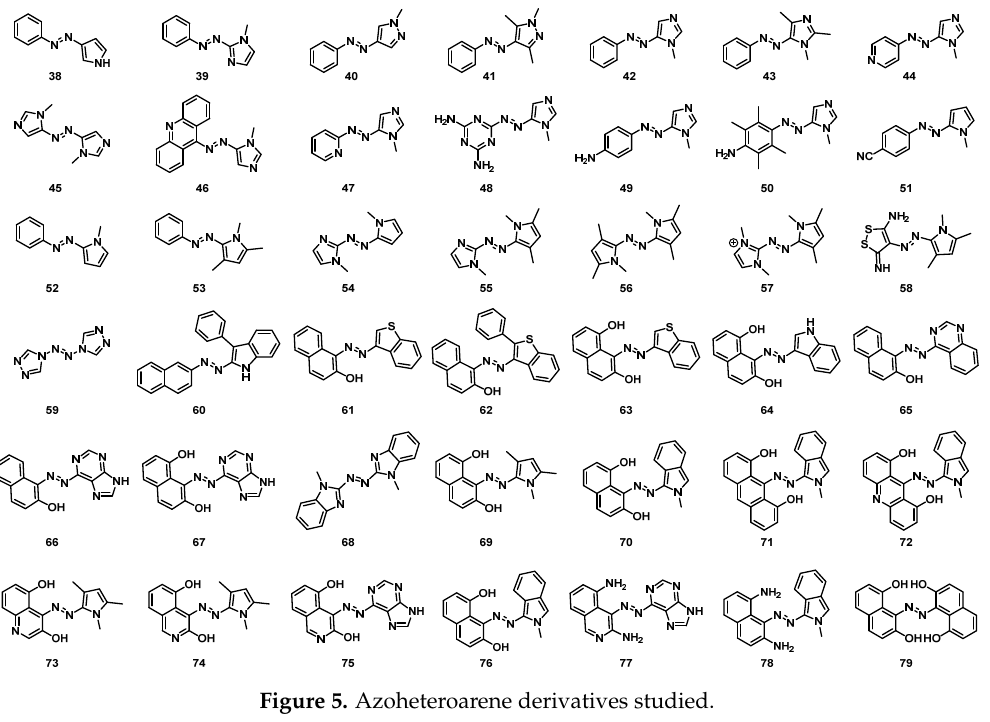
Figure 5 . Azoheteroarene derivatives studied. Figure 5. Azoheteroarene derivatives studied.